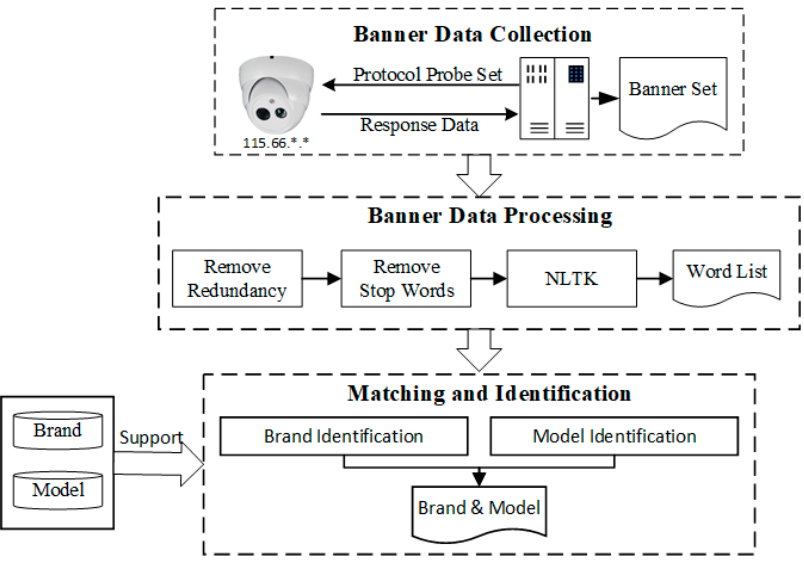
Figure 3. Banner-based webcams identification process.